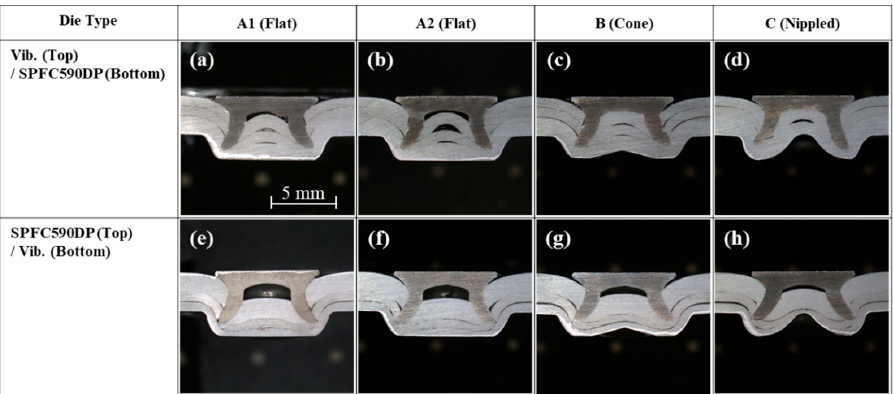
Figure 5. The cross-sectional images of the self-piercing riveted joint between vibration-damping steel and SPFC590DP with respect to die types and panel configurations: ( a , e ) die type A1, ( b , f ) die type A2, ( c , g ) die type B, ( d , h ) die type C.